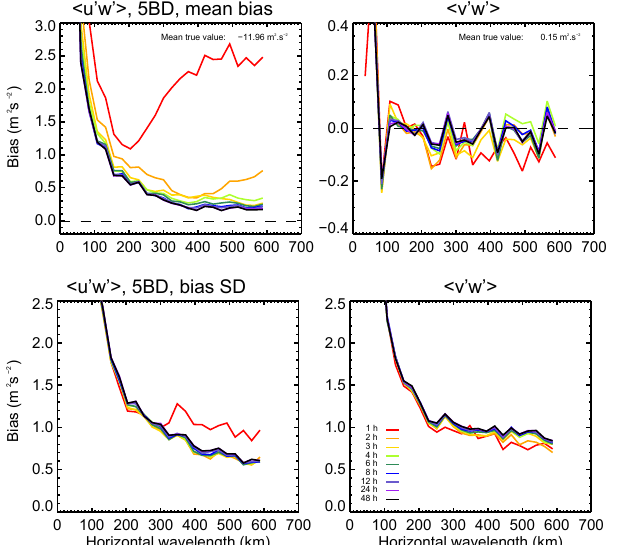
Figure 8. As per Fig. 7, but for the all-sky meteor